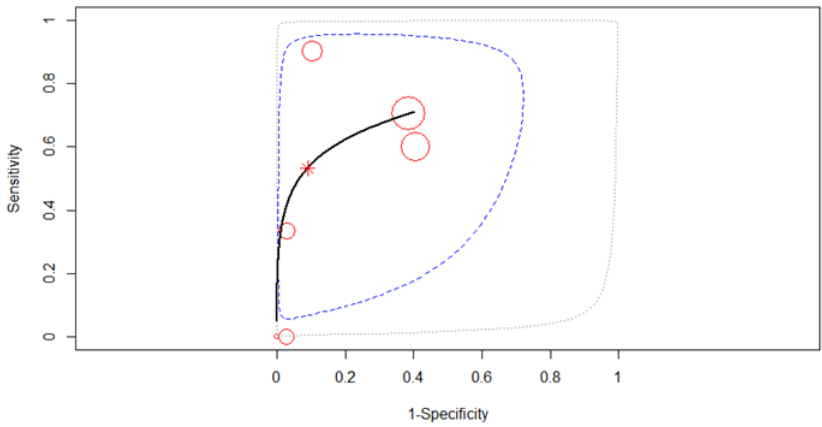
Figure 9. SROC curve with 95% confidence and prediction regions for T4 restaging.